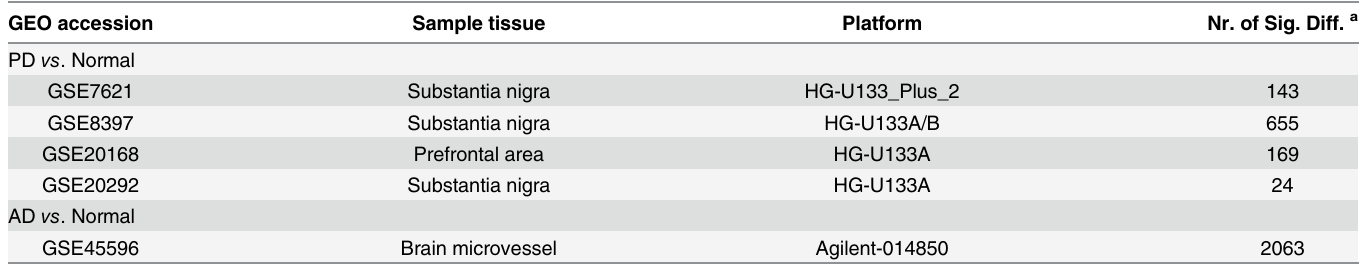
Table 1. List of selected gene expression data